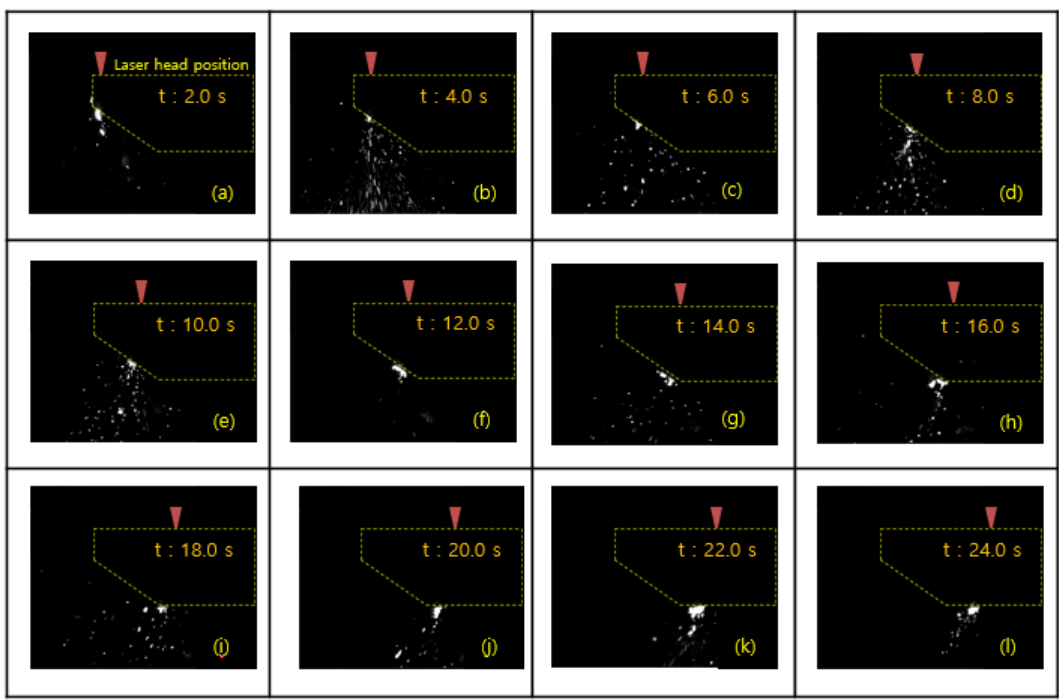
Figure 7. Molten pool behavior and evacuation captured by the high-speed camera in case 3 at ( a ) t: 2.0 s, ( b ) t: 4.0 s, ( c ) t: 6.0 s, ( d ) t: 8.0 s, ( e ) t: 10.0 s, ( f ) t: 12.0 s, ( g ) t: 14.0 s, ( h ) t: 16.0 s, ( i ) t: 18.0 s, ( j ) t: 20.0 s, ( k ) t: 22.0 s, and ( l ) 24.0 s.